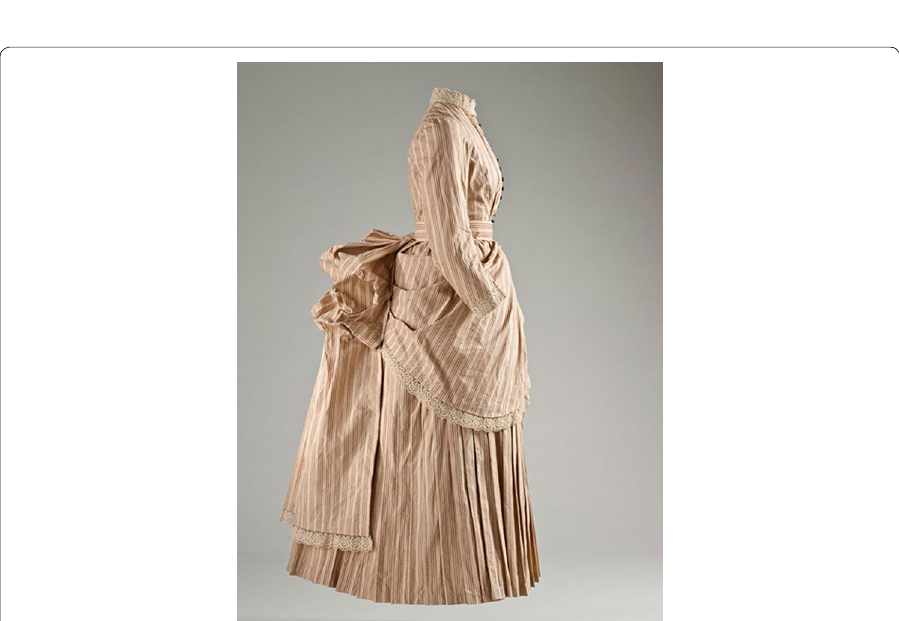
Fig. 3 Tennis Dress c.1885. The Los Angeles County Museum of